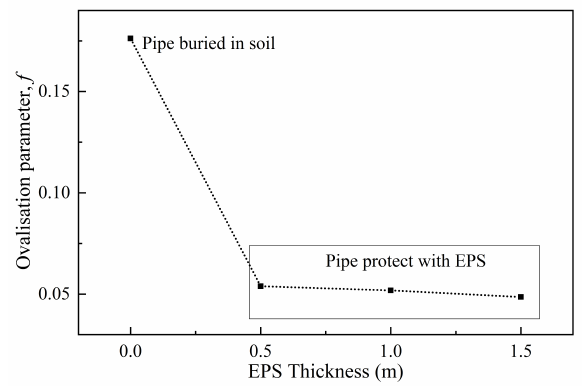
Fig. 13. Ovalisation parameter of pipe with different EPS